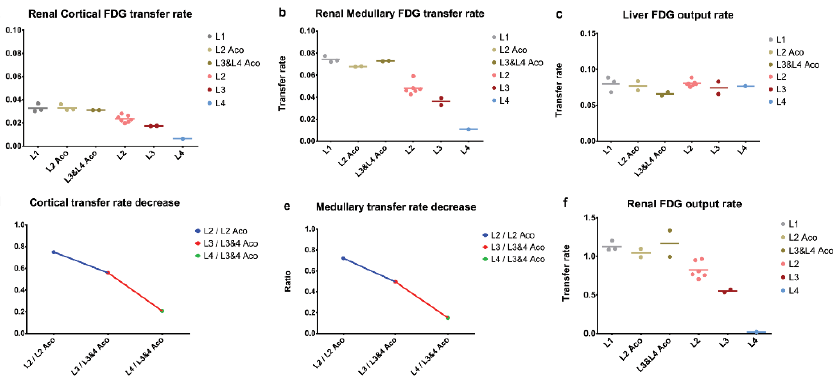
Figure 10. Patlak graphical analysis results for the cortex, medulla, pelvis (renal FDG output rate), and liver, with every individual depicted as a dot, and the line representing the average group value ( a – c , f ), together with the evolution of the cortex and medulla expressed as ratios, between L2, L3, and L4 and their respective age control groups ( d , e ).